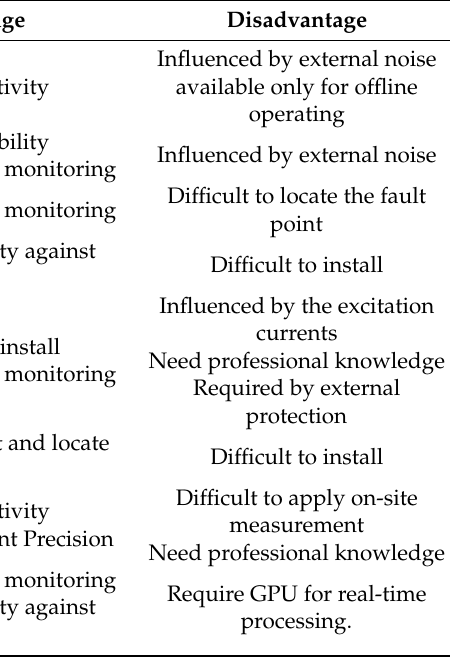
Table 1. Summary of the related work for power transformer